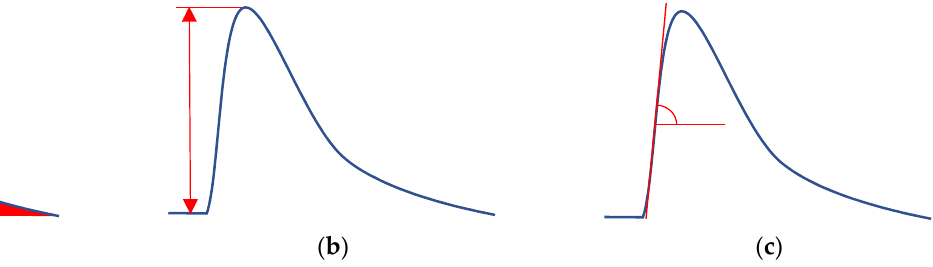
Figure 2. Dependences of the oxygen concentration in the analyzed microvolume on time from the moment the sample was injected into the flow for different concentrations: ( a )—Clark electrode current; ( b )—indicator dye excited state lifetime. Flow rate 1 mL · min − 1 , loop volume 0.2 ml.